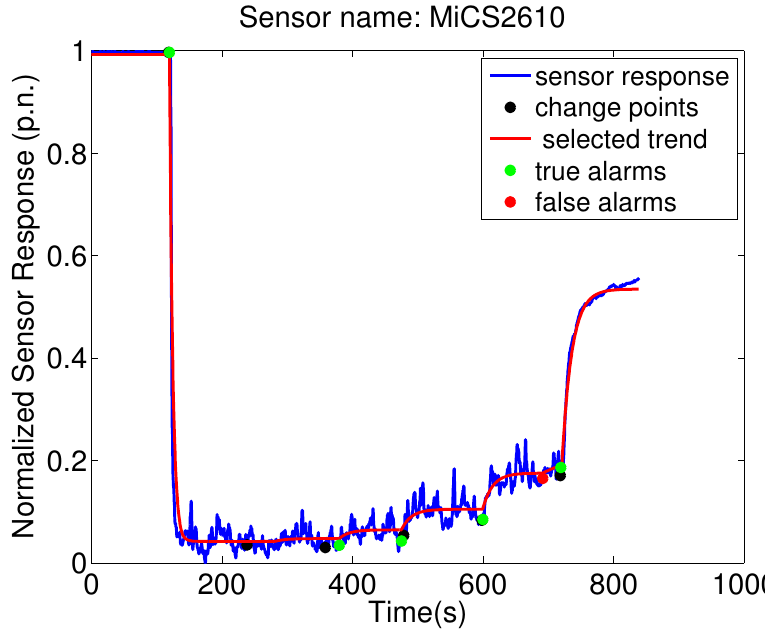
Figure 6. Result of the execution of the proposed algorithm for an experiment where the gas source was changing the emitted concentration using the Descending Stairway strategy ( 0% , 100% , 80% , 60% , 40% , 20% and 0% of gas source strength). The regularization parameter is set to λ = 4